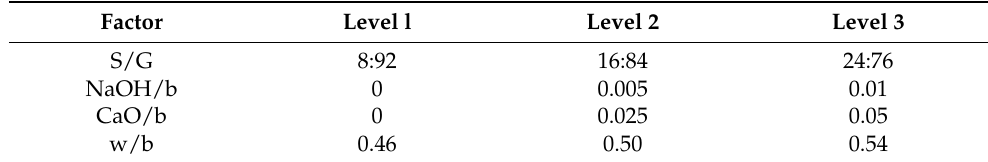
Table 2. Group I, 4 factors and 3 levels selected for the experimental design. Factor